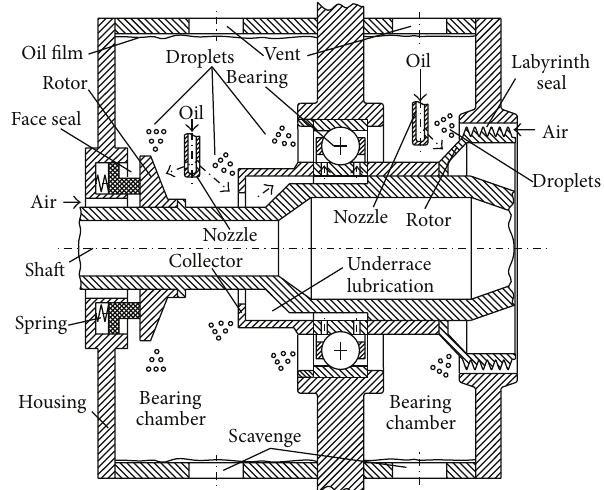
Figure 1: Droplet generation and oil/air two-phase flow in a bearing chamber.